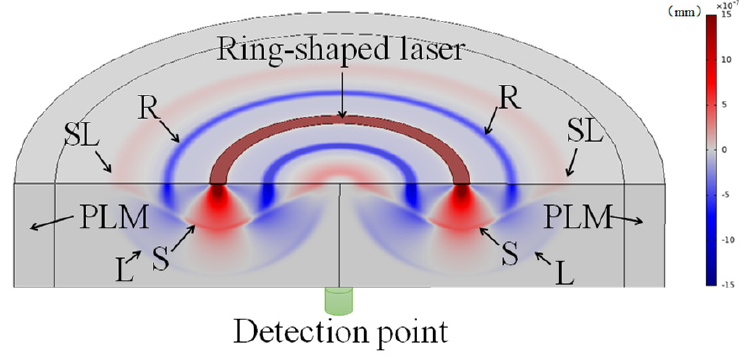
Figure 2. Schematic of the simulation based on COMSOL.